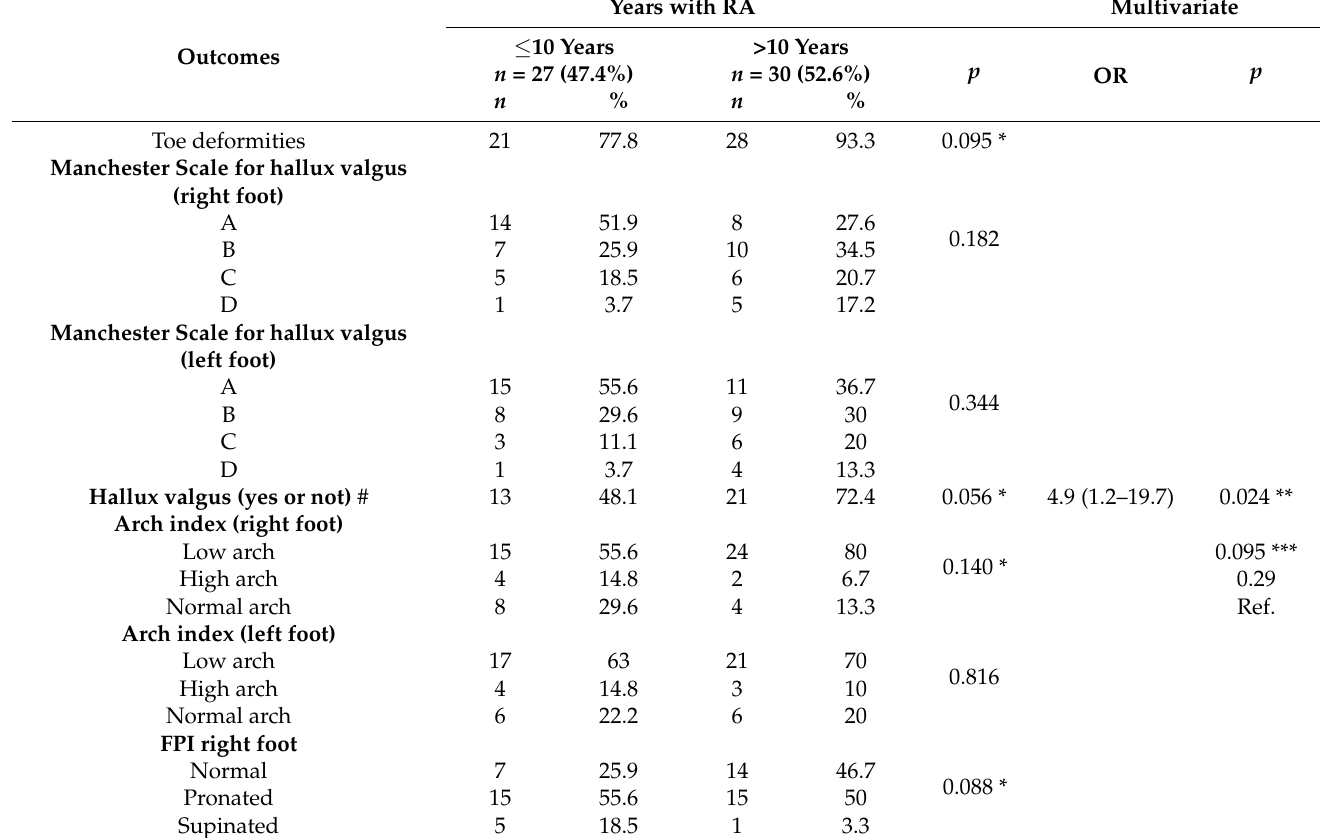
Table 4. Participants’ characteristics, foot problems, and values for different scales employed in patients with 10 years or less with RA and those with more than 10 years with